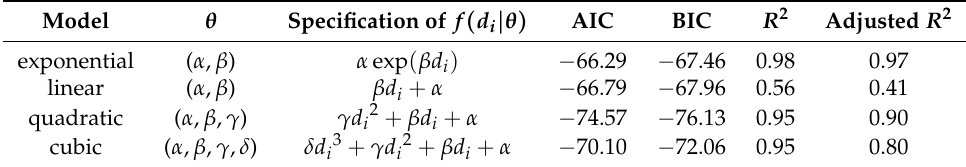
Table 2. Model evaluation through several criteria: Akaike information criterion (AIC), Bayesian information criterion (BIC), R 2 and adjusted R 2 . The best statistical model corresponds to an exponential function where θ = ( α , β ) = ( 1.01266 10 − 3 ; 4.17805 10 − 3 ) . × ×